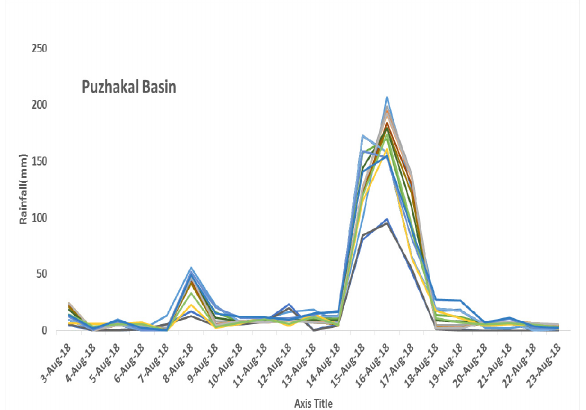
Figure 15c: Daily flow obtained from HEC-HMS for outlets and major dams of Puzhakal river basin.